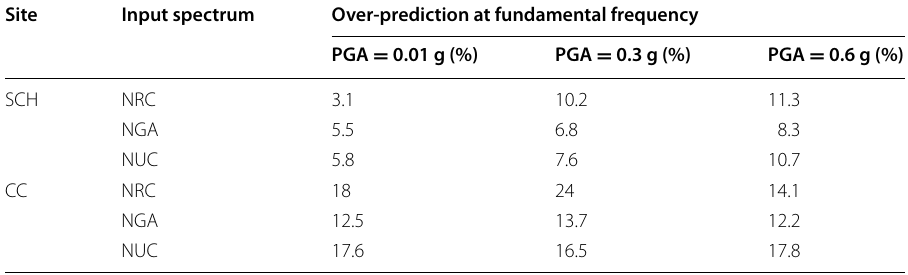
Table 1 Maximum over‑predictions for the SCH and CC sites at different levels of intensity